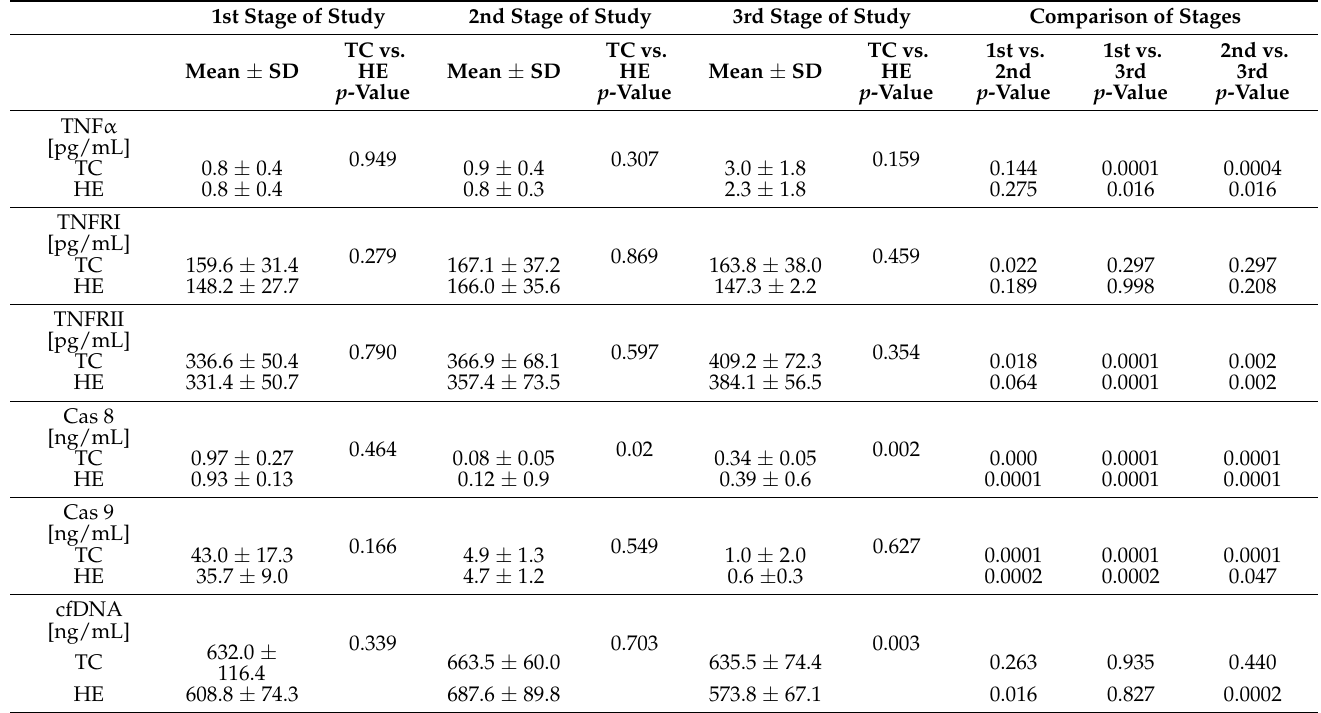
Table 6. The levels of inflammatory and apoptotic